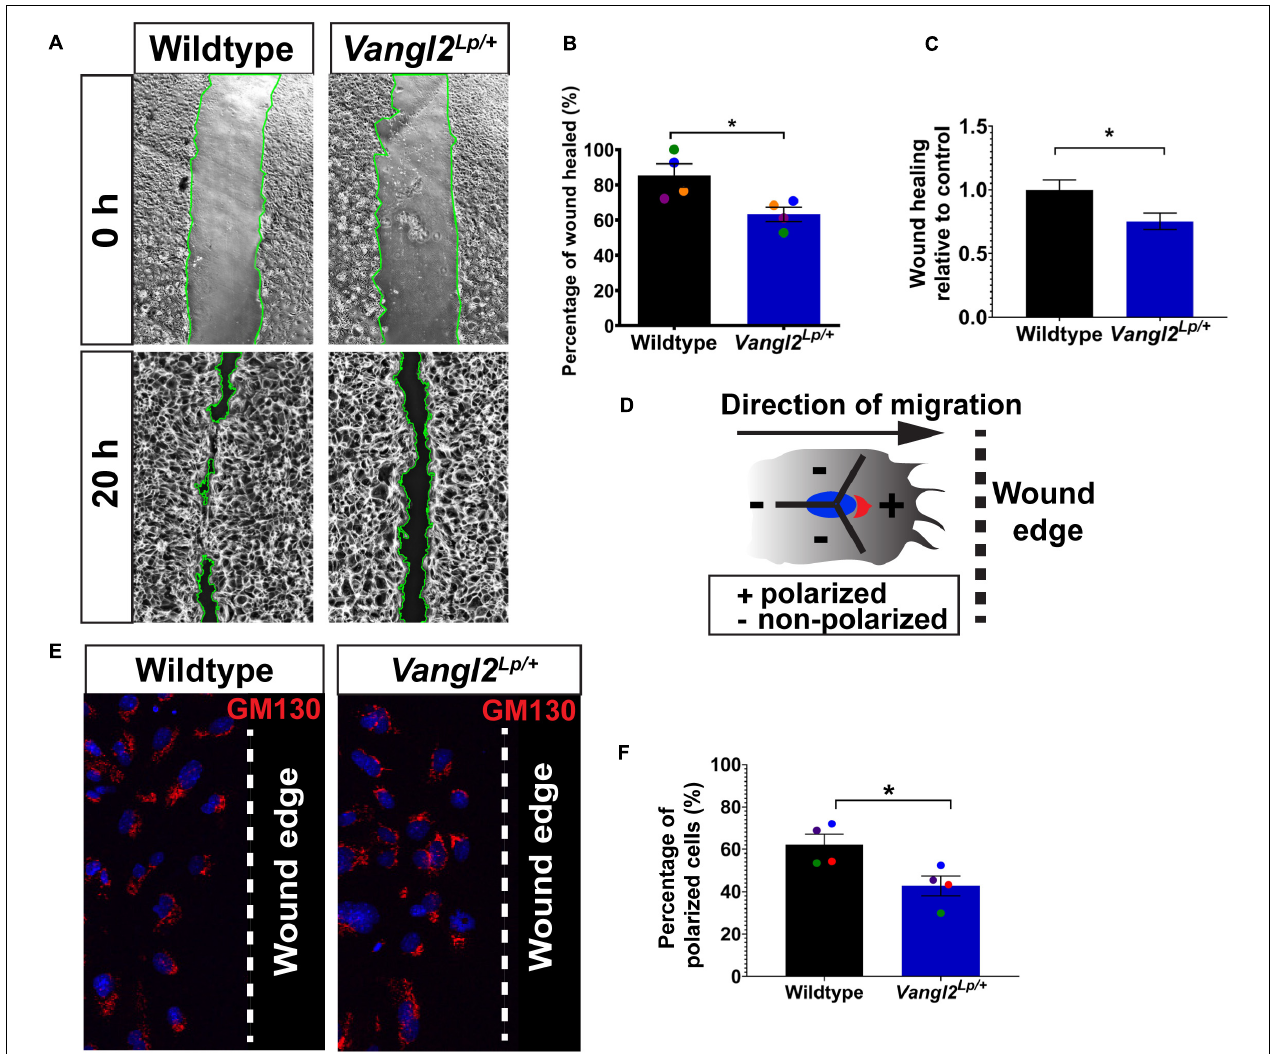
FIGURE 2 | Cell polarity and wound-healing are impaired in Vangl2 Lp / + TECs. (A) Representative images showing wildtype (left panels) and Vangl2 Lp / + TECs (right panels) at 0 and 20 h post-scratch. Wound edges are indicated by green lines. (B) Percentage of wound healed measured at 20 h post-scratch in wildtype and Vangl2 Lp / + TECs. n = 4 independent experiments; TECs from three mice were pooled for each group per experiment; three technical replicates for each group per experiment; each dot represents mean percentage of wound healed per experiment. Mann–Whitney U -test, * p = 0.029. (C) Wound-healing rate in Vangl2 Lp / + relative to wildtype control. n = 4 independent experiments. Mann–Whitney U -test, * p = 0.029. (D) Schematic to illustrate polarized or non-polarized cells at leading edge as determined by the 120 ◦ arc drawn from the center of a nucleus (blue) facing the direction of migration (arrow). Golgi (red) that are located within the 120 ◦ arc (+) were considered as polarized, whereas cells with the entire or majority of the Golgi localized outside the 120 ◦ arc were classed as non-polarized. Arrow shows the direction of migration and dotted line indicates the wound edge. (E) Immunostaining for Golgi marker GM130 (red) in fixed wildtype and Vangl2 Lp / + TECs at 20 h post-scratch. Nuclei were labeled with DAPI (blue). Dotted line indicates the wound edge. (F) Percentage of polarized cells at 20 h post-scratch in wildtype and Vangl2 Lp / + TECs. n = 4 independent experiments; TECs from three mice were pooled for each group per experiment; three technical replicates for each group per experiment; each dot represents mean percentage of wound healed per experiment. Mann–Whitney U -test, * p < 0.05. All data are presented as mean ±